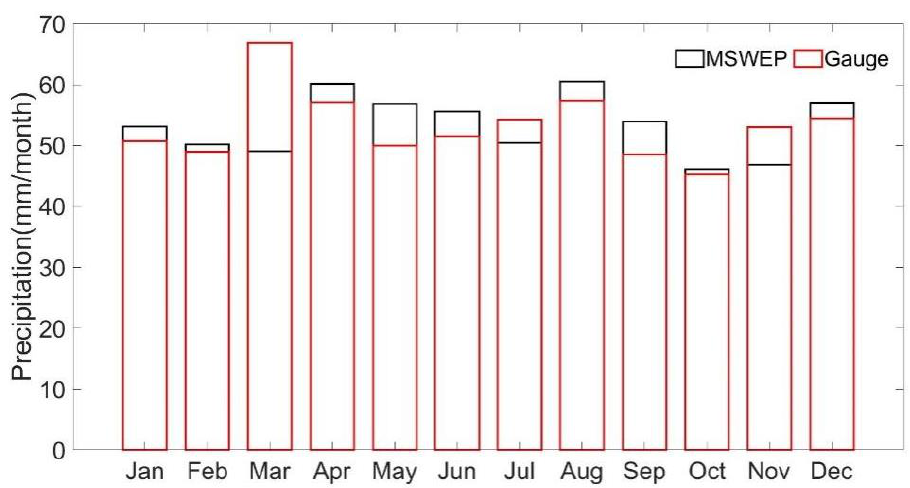
Figure 4. Multi-year precipitation maps of the sites and MSWEP.